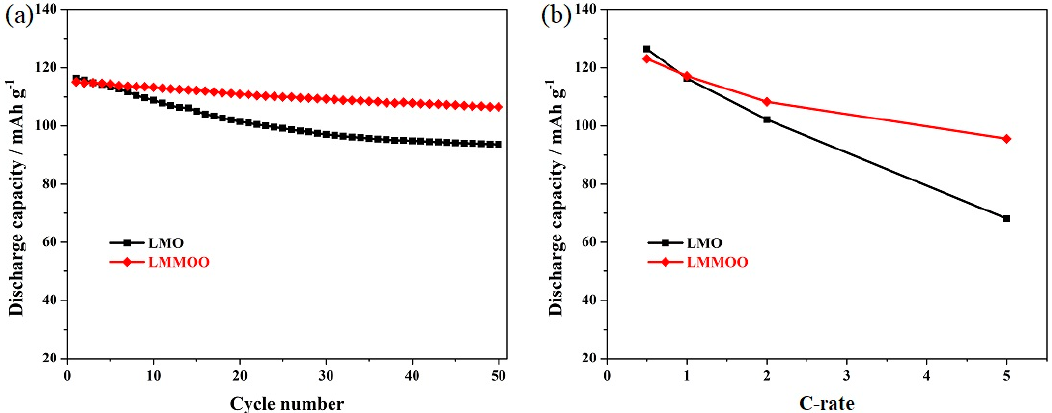
Figure 7. ( a ) Cycling stability of the LiMn 2 O 4 and octahedral LiMn 1.95 Mg 0.05 O 4 samples at 1.0 C under high temperature (55 °C), and ( b ) representative discharge curves of the octahedral LiMn 1.95 Mg 0.05 O 4 sample.